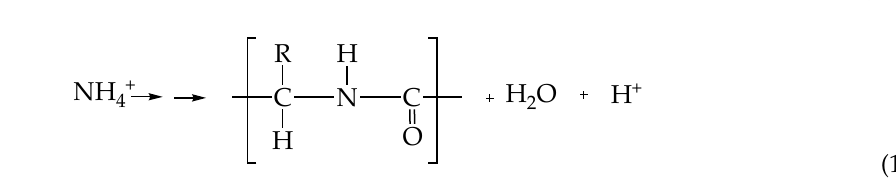
Figure 2. pH measurements and biomass growth curves, with standard deviations, of two cultures of C. sorokiniana cultivated in AWW. In black, the biomass concentration, and in gray, the pH values. The boxes represent the pH-controlled culture, and the triangles, the pH-uncontrolled culture. Orange boxes indicate the pH values before the KOH addition. Red boxes indicate the pH value before HCl addition. Number of samples per treatment =